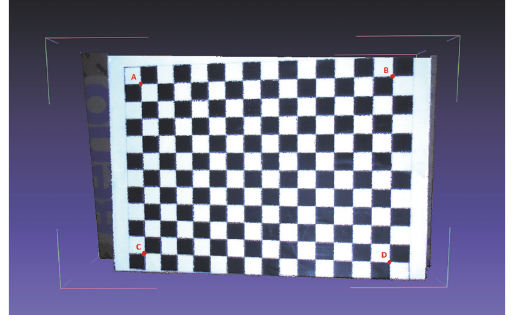
Figure 10: The 3D reconstruction of a checkerboard shown with Meshlab software. We used a measuring tool of the Meshlab to measure